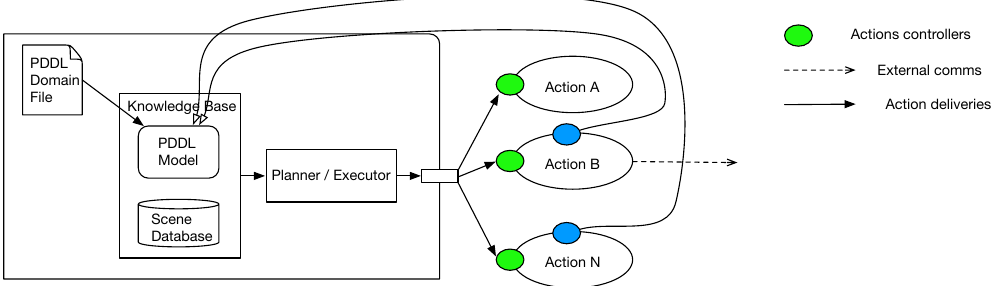
Figure 4. The components of a planner system.